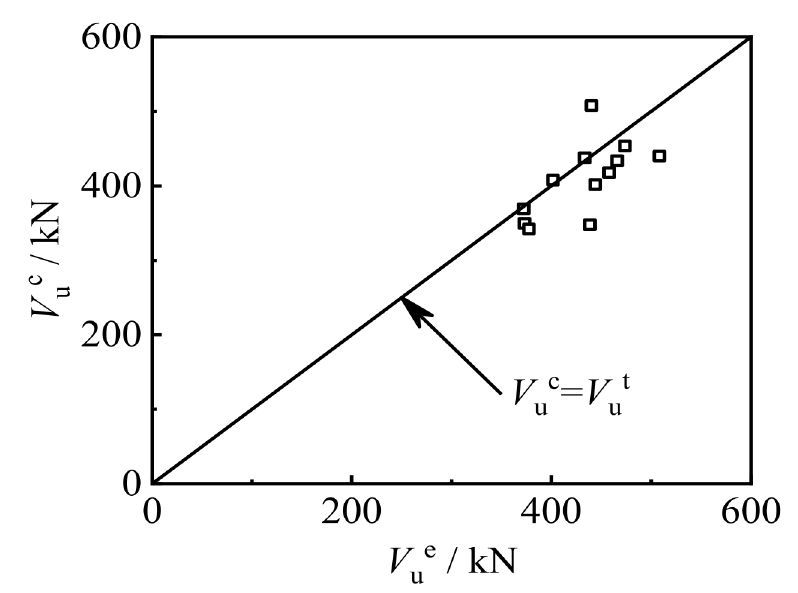
Figure 16. Comparison between V uc and V ut of concrete-filled CFRP steel tube shear